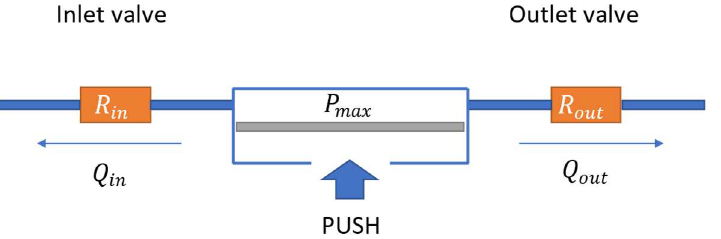
Figure 5. Schematic representation of the micropump during leak tests. The pressurized air in the pumping chamber flows through the residual fluid pathways of the inlet and outlet valves in closed positions. The direction of the airflow is indicated by blue arrows.